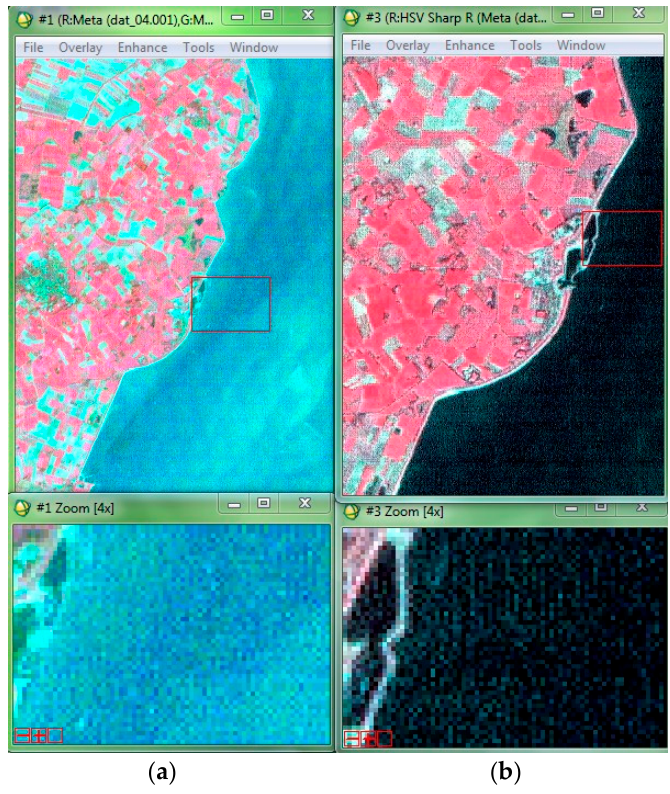
Figure 5. ( a ) Original image with a resolution of 30 m; ( b ) Fused image with a resolution of 15 m.